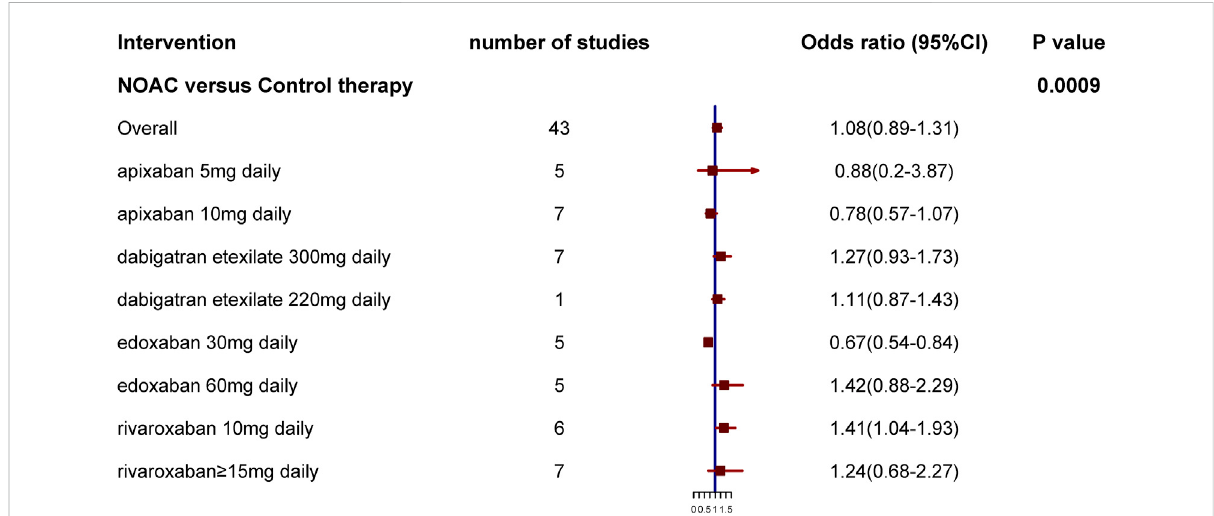
FIGURE 3 Results of subgroup analysis based on dosages and type of direct oral